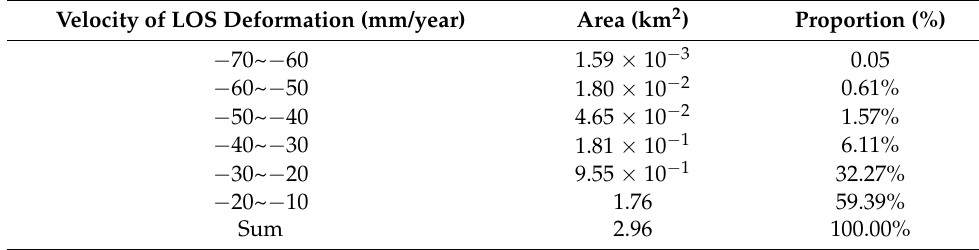
Figure 17. Distribution map of active rockfall source areas in the Taihang GCSA . Table 6. Activity identification results of potential rockfall source areas. Table 6. Activity identification results of potential rockfall source